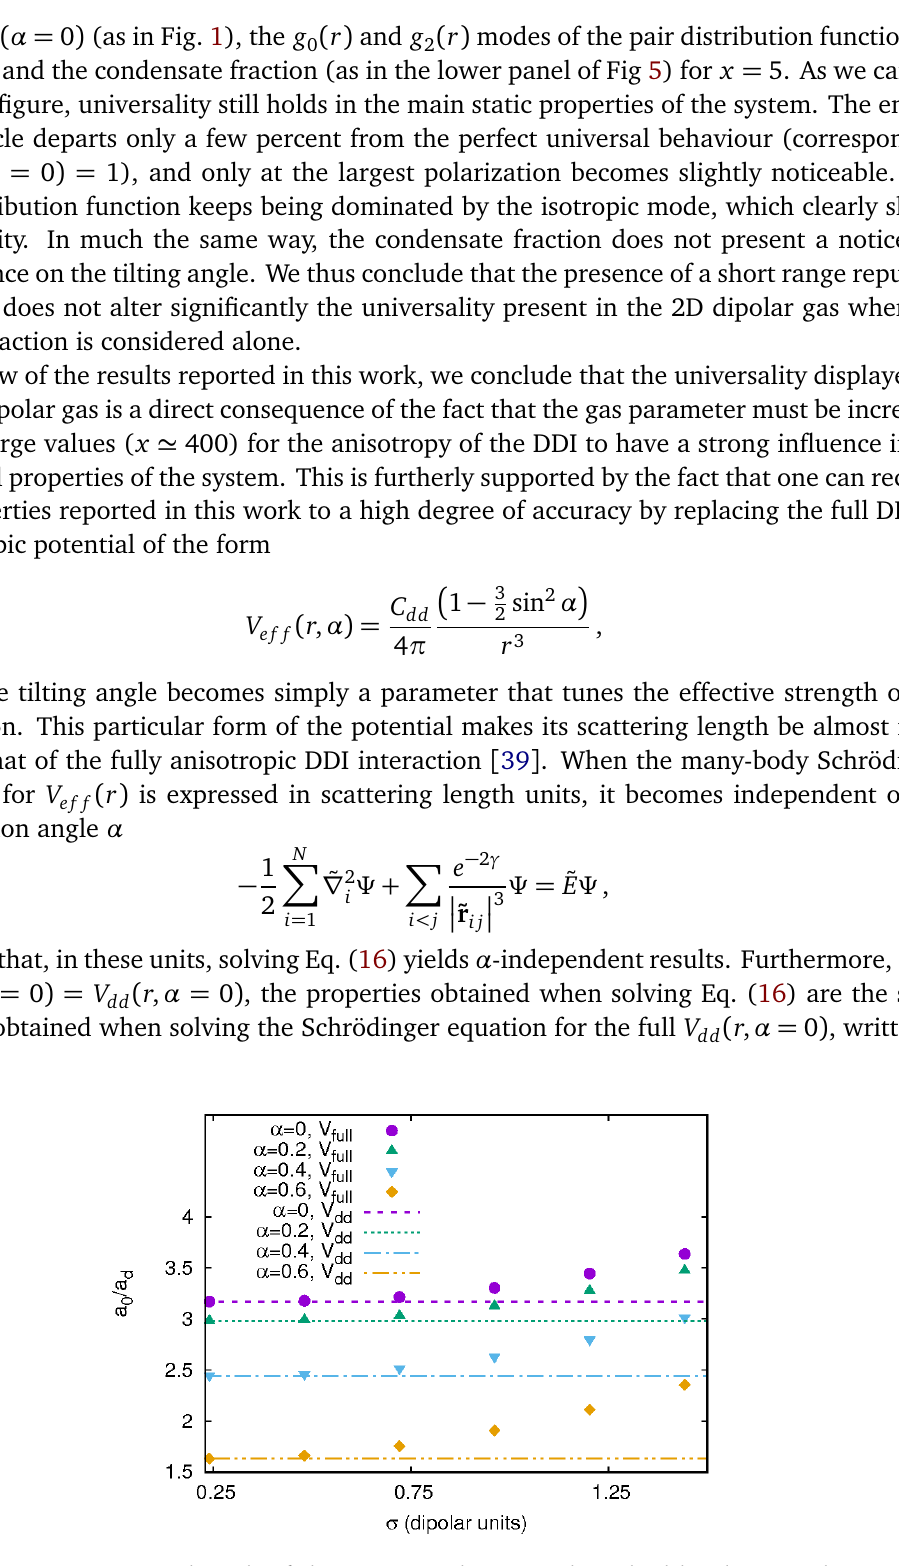
= ħ h 2 / ma 2 , ε d l d